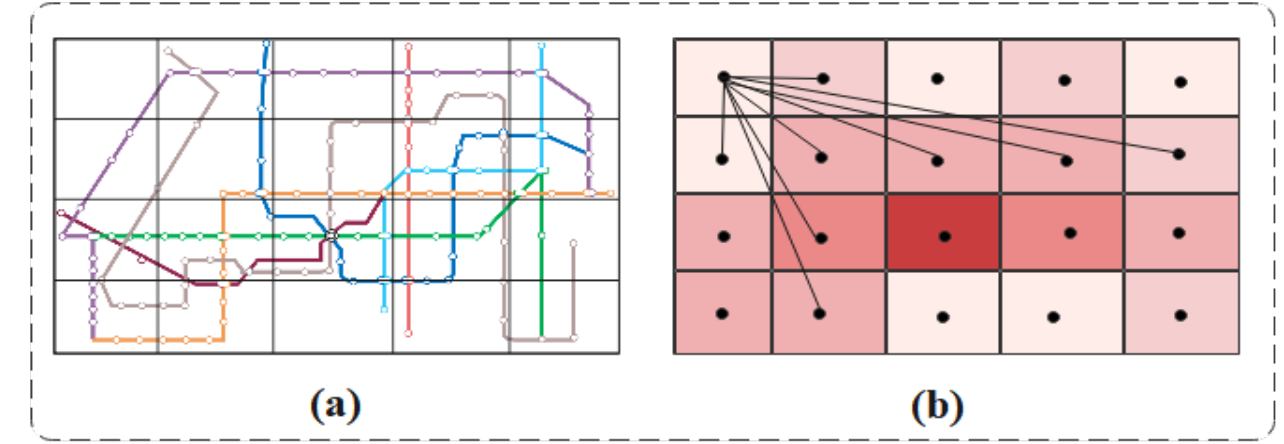
Figure 2. Grid division method. ( a ) The traffic network is divided into grids, and each grid represents an independent area. ( b ) The center points of the grid are abstracted as nodes. The darker the color, the more severe the congestion.